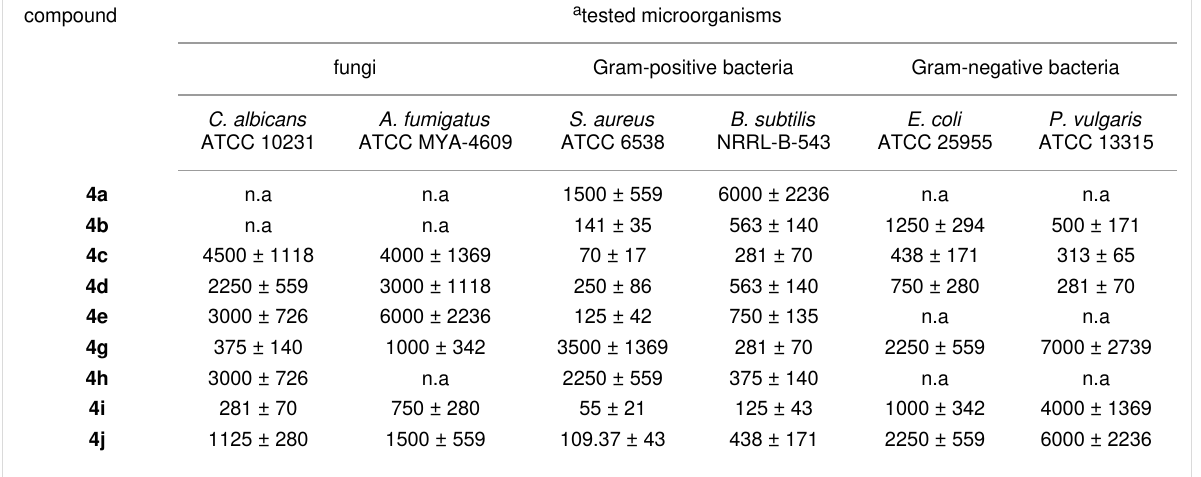
Table 2: Minimum inhibitory concentrations (MIC, µg/mL) of the synthesized compounds determined by microdilution method.